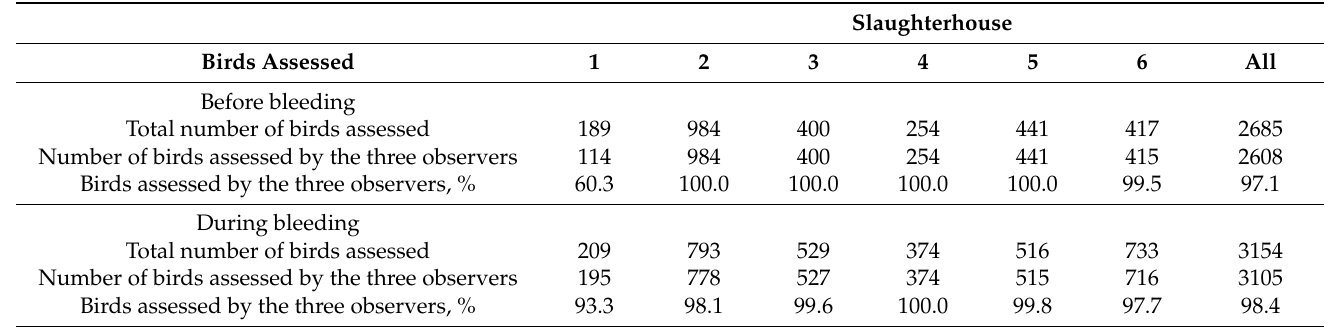
Table 4. Number of assessed animals and number and percentage of birds that were able to be assessed by the three observers according to the slaughterhouse (before and during bleeding).